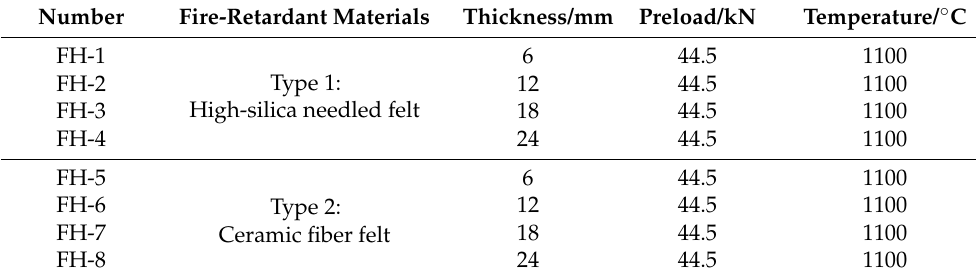
Figure 9. Specimen of fire resistance test.